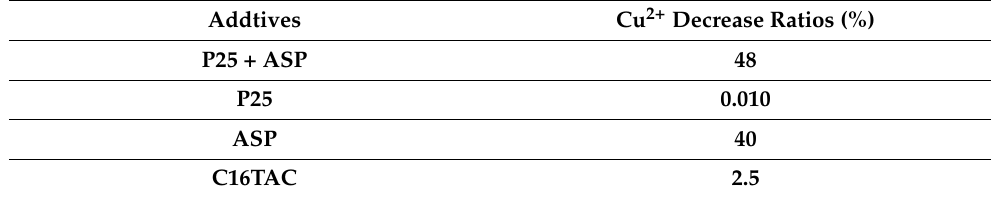
Figure 5. XPS spectrum of Cu–P25–ASP. Table 1. Ratios reflecting the decrease in Cu 2+ concentration after irradiation of the additives com- bined with the starting solution.